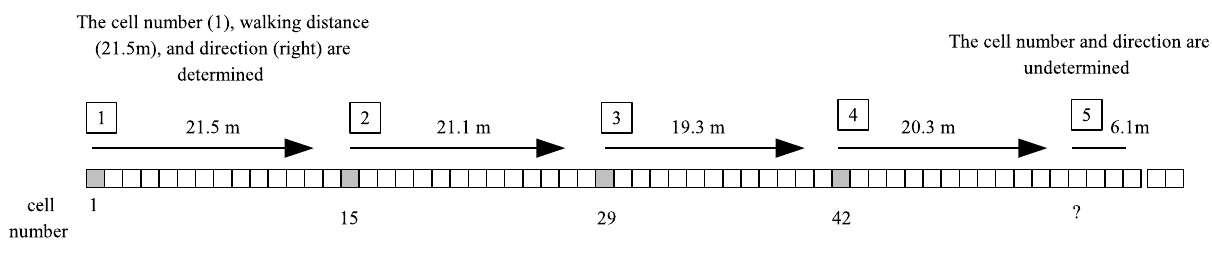
Figure 11. Estimated location in Table 4 (first 5